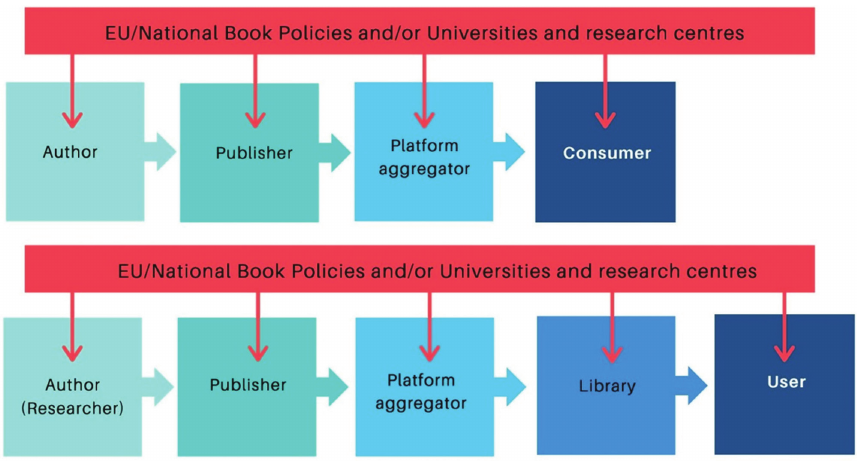
Fig. 3: Commercial and non-commercial scholarly communication